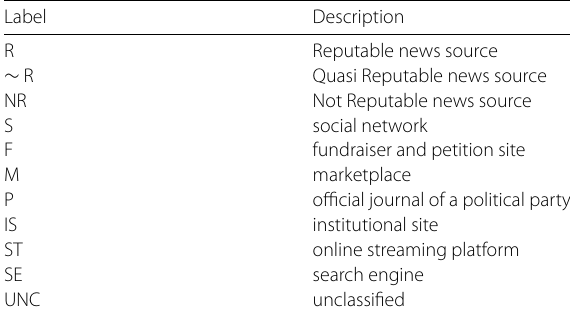
Table 2 Tags used for domain labeling